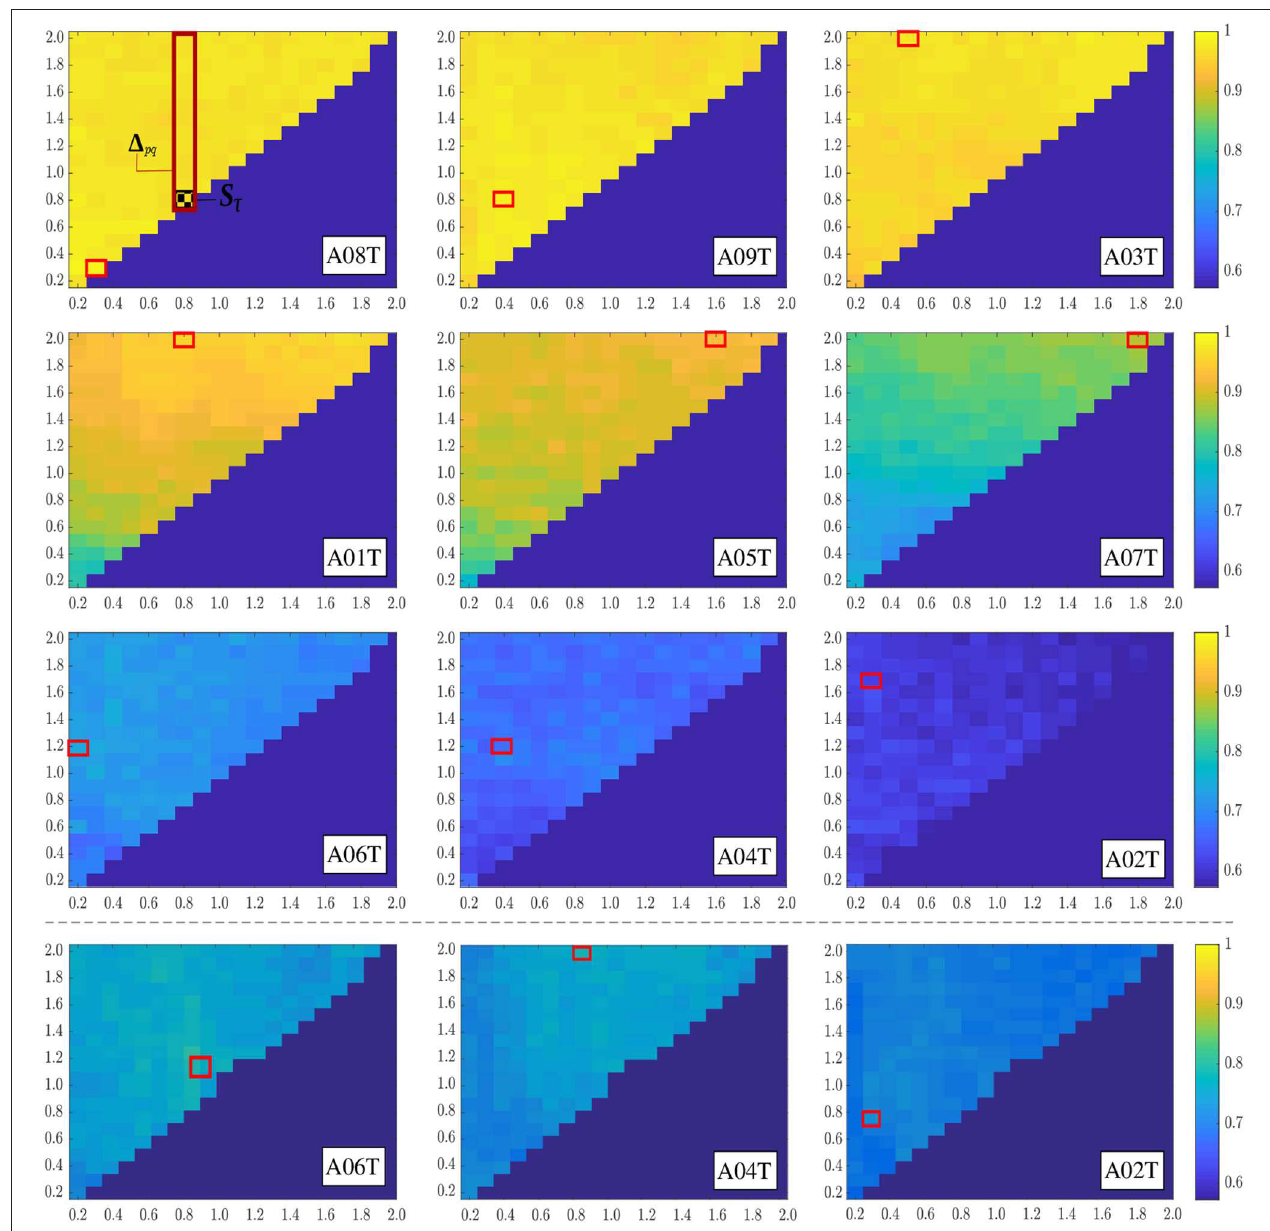
FIGURE 3 | Accuracy performed at different window length combinations of atom-based instances. The last row beneath the dotted line displays the subject performance with a lower accuracy (A06T, A04T, and A02T) after using the optimization of the atom-based MIL representation